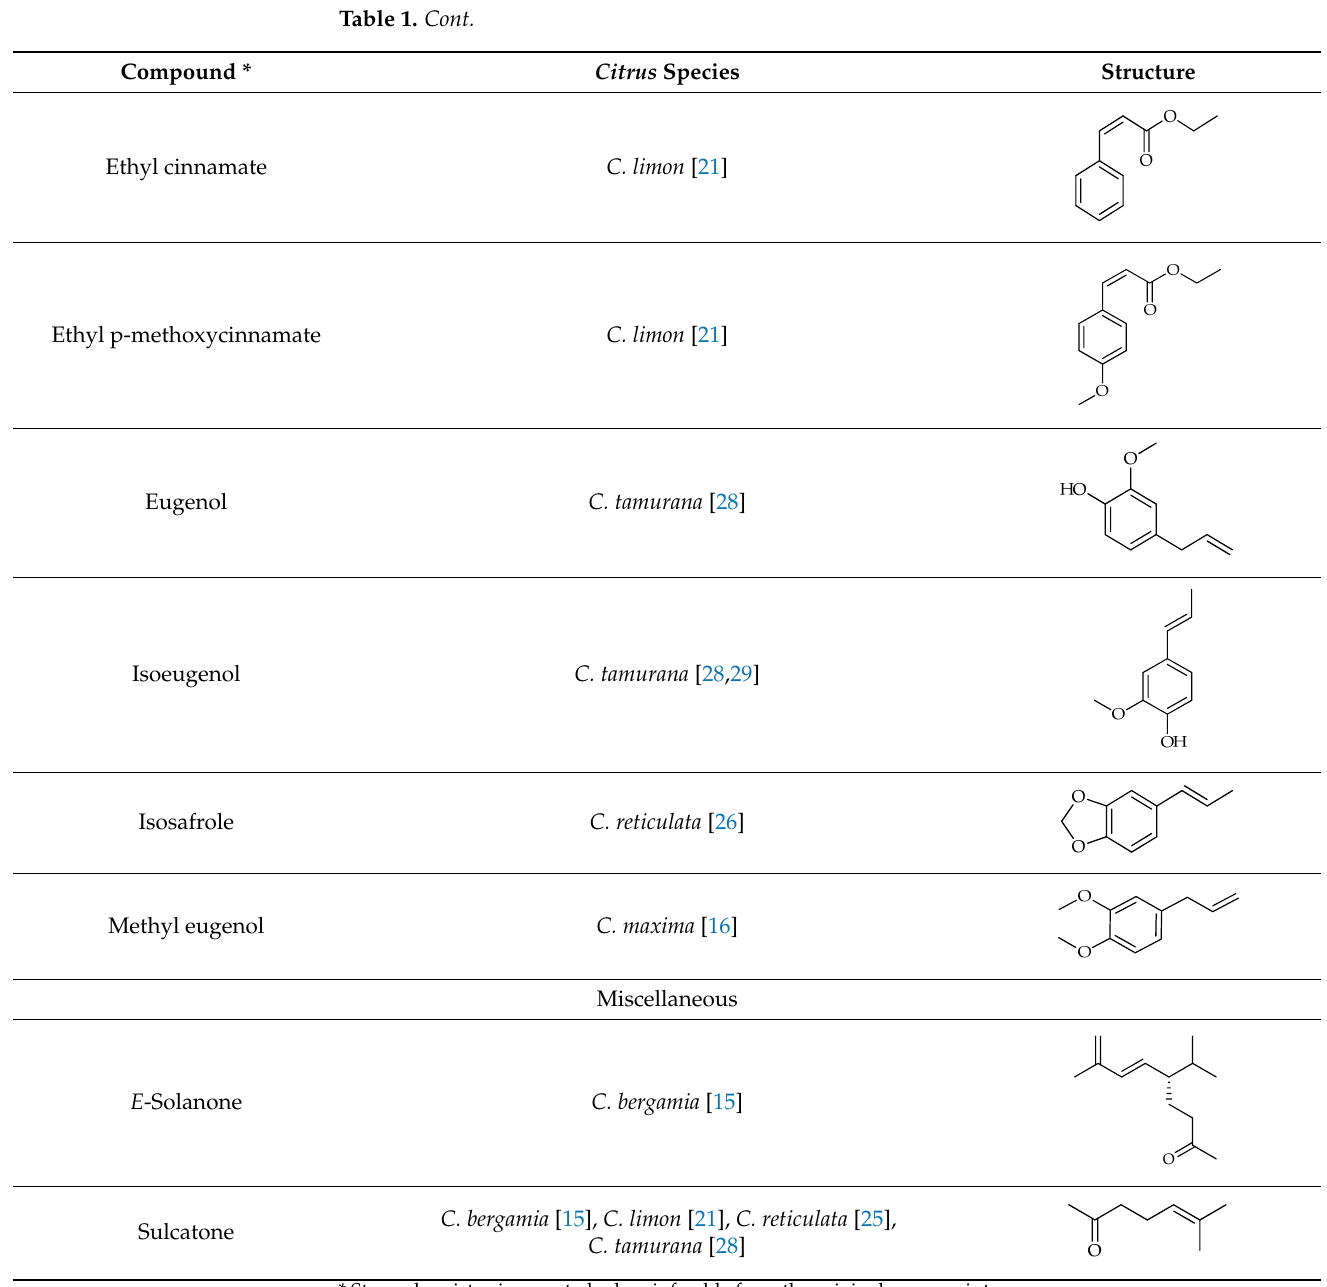
3. Main Changes in the Essential Oils Content during Fruit Maturation The fruit quality attributes (e.g., juice color, flavor, seed presence, shape, peel color,